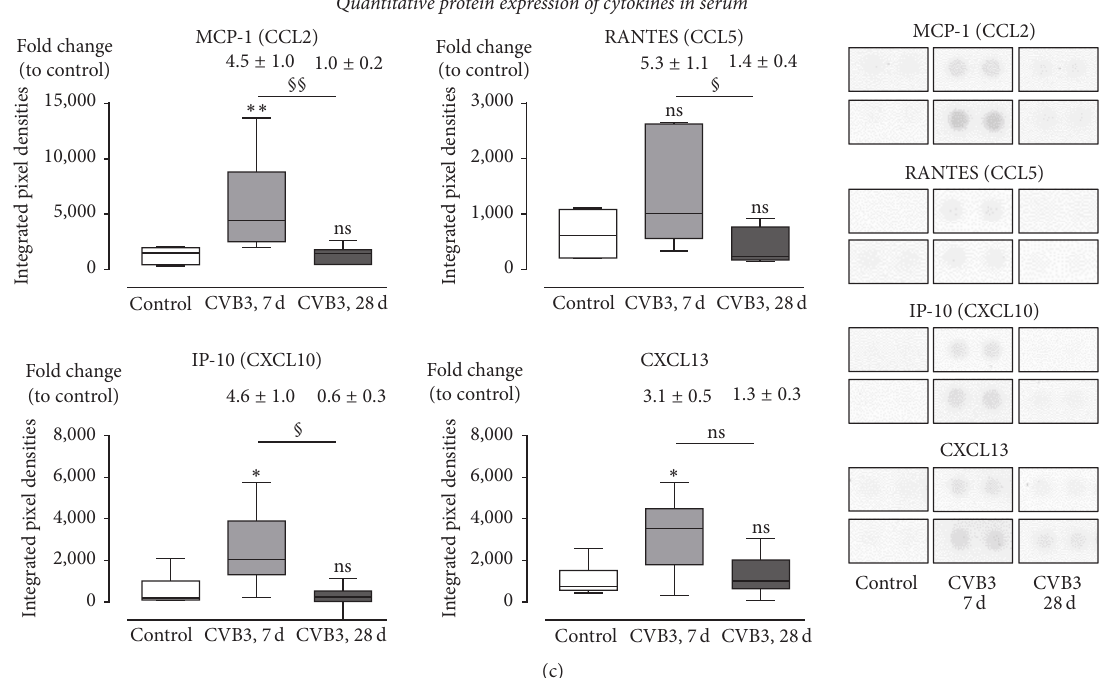
Figure 4: Cytokine expression in cardiac tissue and serum of CVB3-infected C57BL/6J mice 7 and 28 days after infection. (a) Cardiac tissue of CVB3-infected C57BL/6J mice was used for TaqMan based gene expression analysis of various chemotactic chemokines and cytokines. The gene expression of chemokines (Ccl2 , Ccl5 , Ccl7 , Cxcl10, and Cxcl13) as well as the expression of Il-6 and Tnf- 𝛼 was highly increased 7 days p.i. compared to healthy controls and returned to basal levels 28 days after infection. Gene expression of Il-23a expression was not altered in cardiac tissue after CVB3 infection. Data are presented as absolute mRNA expression ( 𝑥 -fold to the house keeping gene 18S) in box plots as well as in fold change to control animals as mean ± SEM above the corresponding bar using the formula 2 −ΔΔ Ct . (b) Protein expression in cardiac tissue was determined using Bioplex. The protein expression of MCP-1 and RANTES was increased 7 days after infection and dropped down 28 days after infection. (c) Protein expression in serum was detected using protein profiler arrays. The chemokines MCP-1, RANTES, IP-10, and CXCL13 were increased in serum samples of CVB3 infected mice 7 days after infection. Expression levels from noninfected control mice are shown as white bars, from CVB3-infected animals 7 days p.i. as light grey bars and from CVB3-infected animals 28 days p.i. as dark- grey bars; ∗ significantly different compared to noninfected mice (control); ∗ 𝑃 < 0.5 ; ∗∗ 𝑃 < 0.01 ; ∗∗∗ 𝑃 < 0.001 ; ∗∗∗∗ 𝑃 < 0.0001 ; § significantly different compared to 7 days p.i.; § 𝑃 < 0.05 ; §§ 𝑃 < 0.01 ; ns not